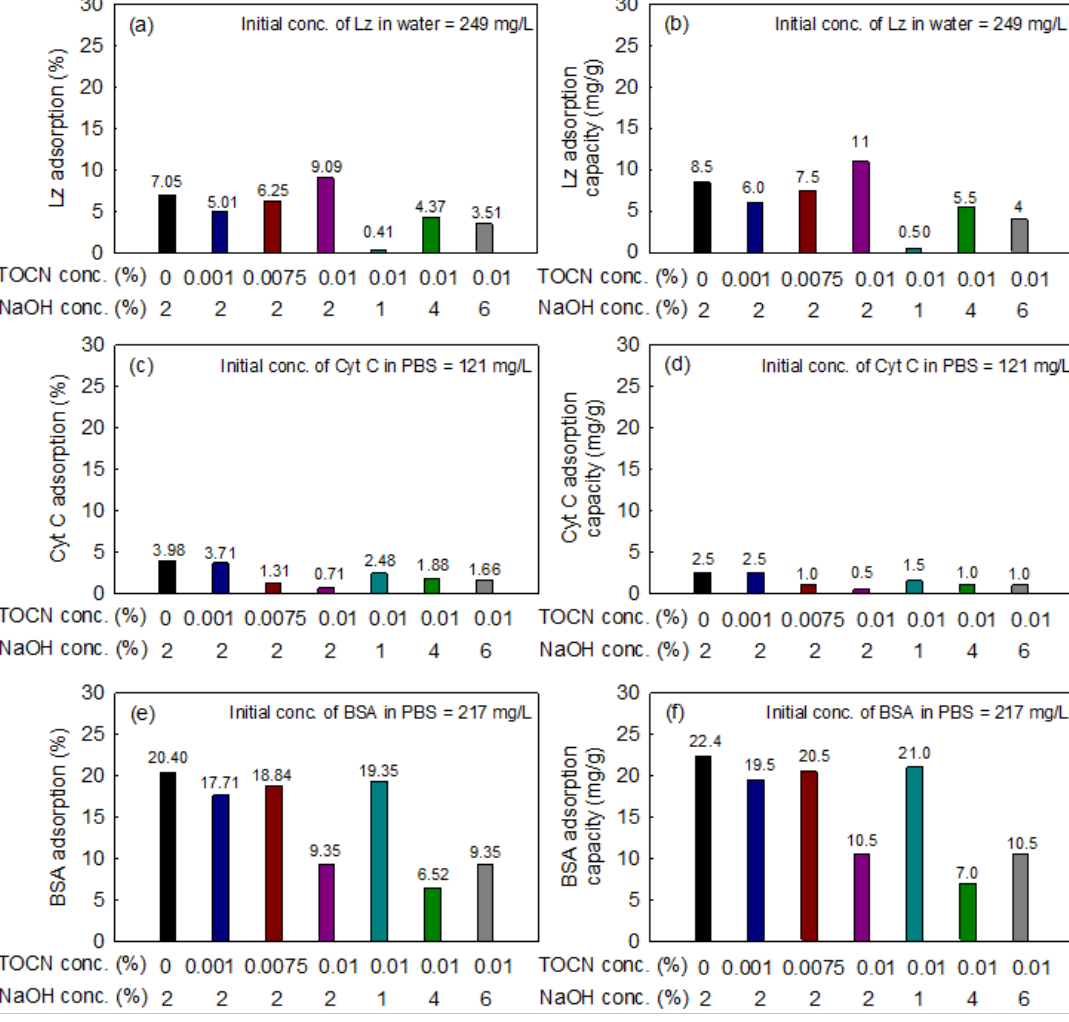
Figure 9. Protein adsorption percentages ( a , c , e ), and protein adsorption capacities ( b , d , f ) for various types of fibers. ( a , b ) Lz; ( c , d ) Cyt C; ( e , f ) BSA.